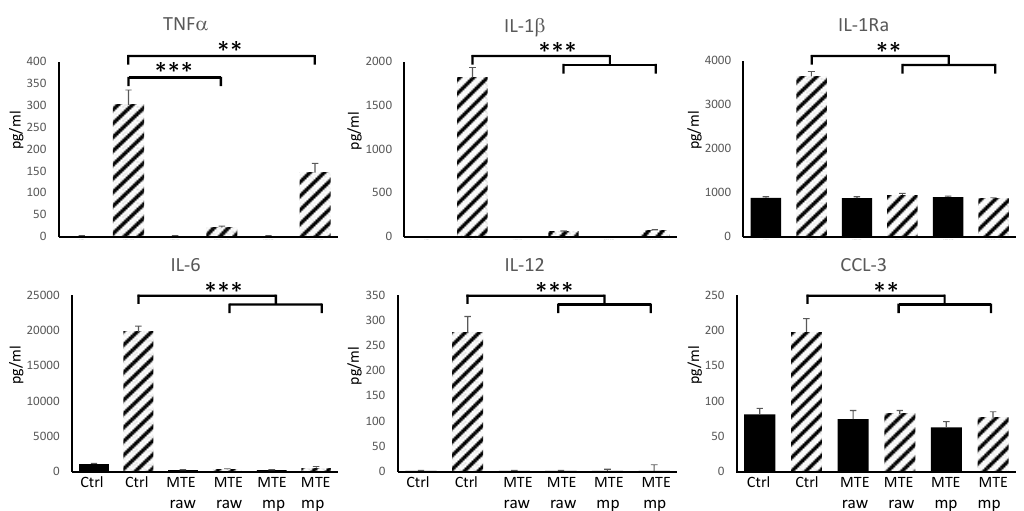
Figure 8. Cytokine secretion by DCs exposed to MTE. Patterned bars represent cytokine concentration in the supernatant of DCs 24 h after LPS administration. DCs exposed to MTE raw material (0.312 mg/mL) or MTE_mp (0.625 mg/mL) fail to produce inflammatory cytokines. MTE exposed DCs in the absence of LPS (filled bars) did not secrete inflammatory cytokines. Data are shown as mean ± S.D. of five independent experiments; ** p < 0.01, *** p < 0.001.